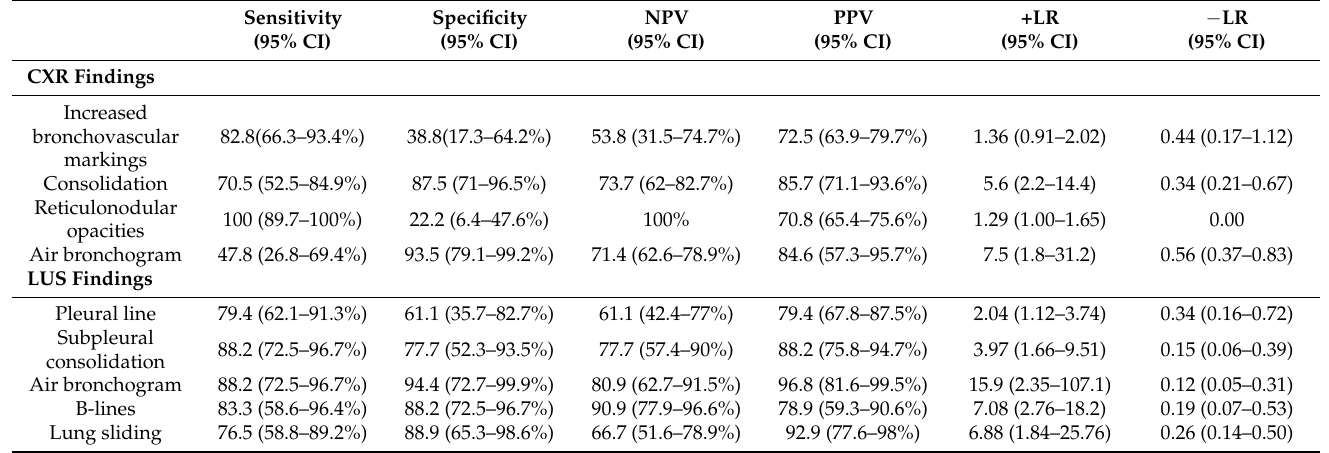
Table 4. Sensitivity, specificity, PPV and NPV for each CXR and LUS